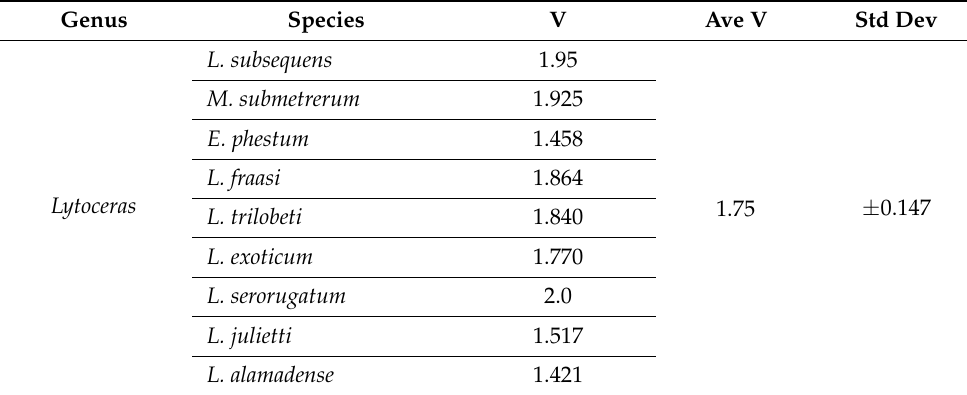
Table 2. Calculation of conversion values (V) for suture lines taken from species of the genus Lytoceras (File S1 in the Supplementary Materials for this manuscript). The conversion values for each species are averaged to determine V for the